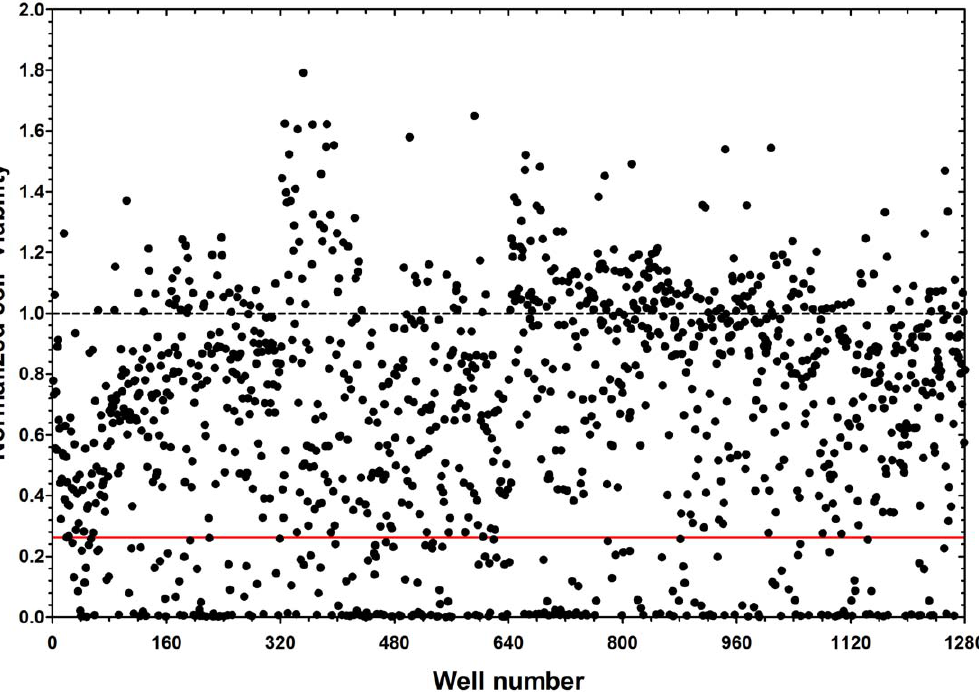
Figure 4. 237 compounds inhibit SCLC cell viability. DMS-53 luc + cells were treated with compounds from the LOPAC 1280 library. Luciferase assays were then performed to measure the effect of the compounds on cell viability. Luciferase values were normalized to the mean luciferase values of the negative control, DMSO (dotted line). The solid red line indicates the mean value for the positive control, cisplatin. Compounds that resulted in inhibition greater than or equal to that of cisplatin were considered hits.